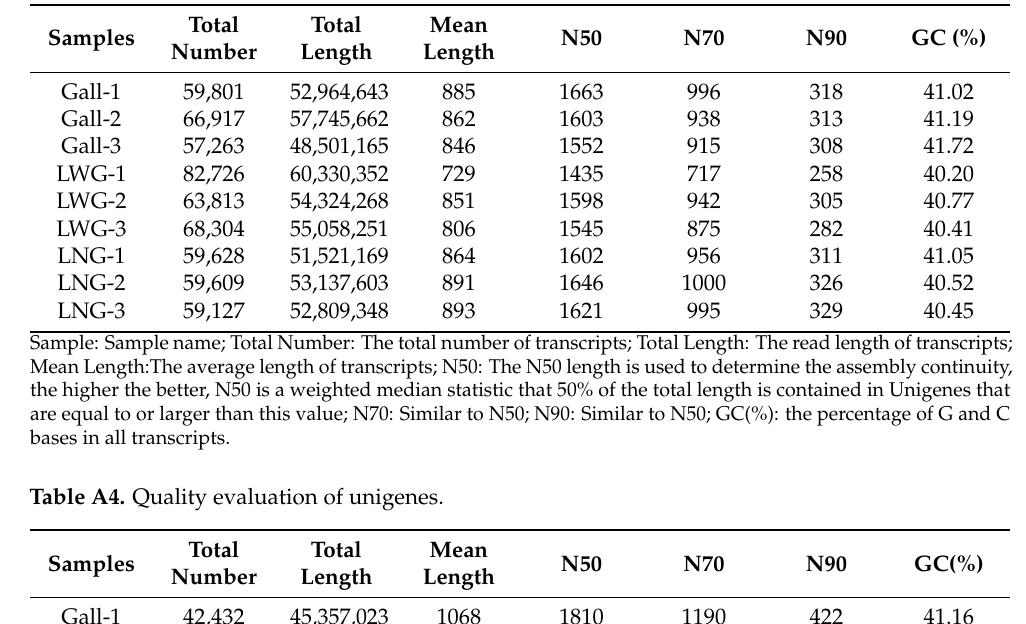
Table A3. Quality evaluation of transcripts.